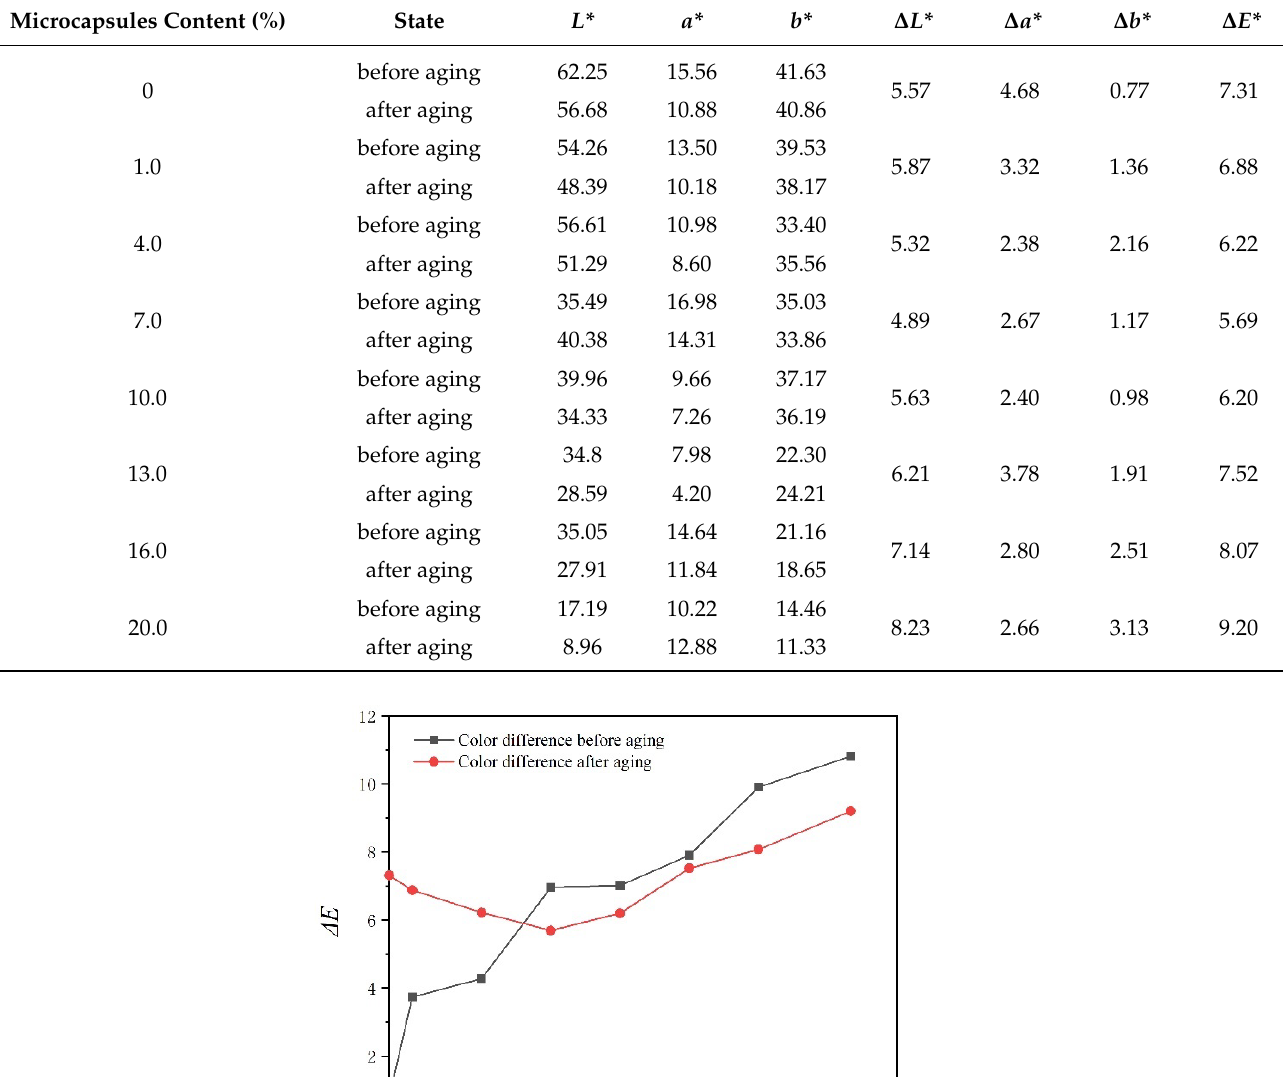
Table 6. Chromaticity value and color difference of the coatings before and after aging.